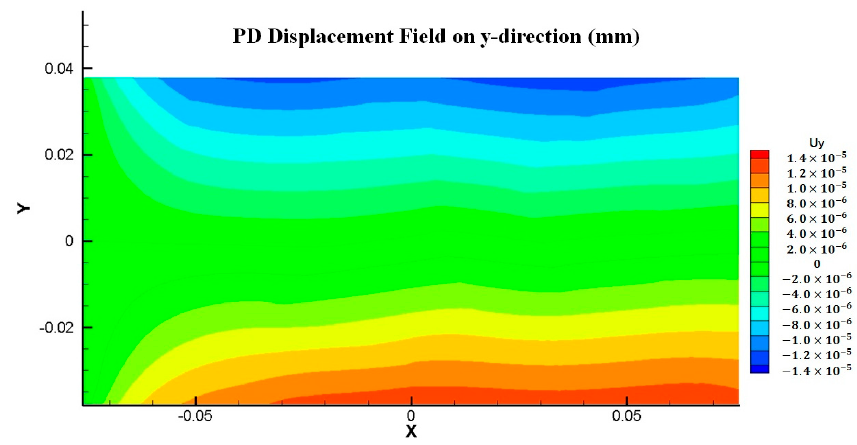
Figure 11. Displacement field comparison between FEM and PD analyses for Mo polycrystal (y-direction).